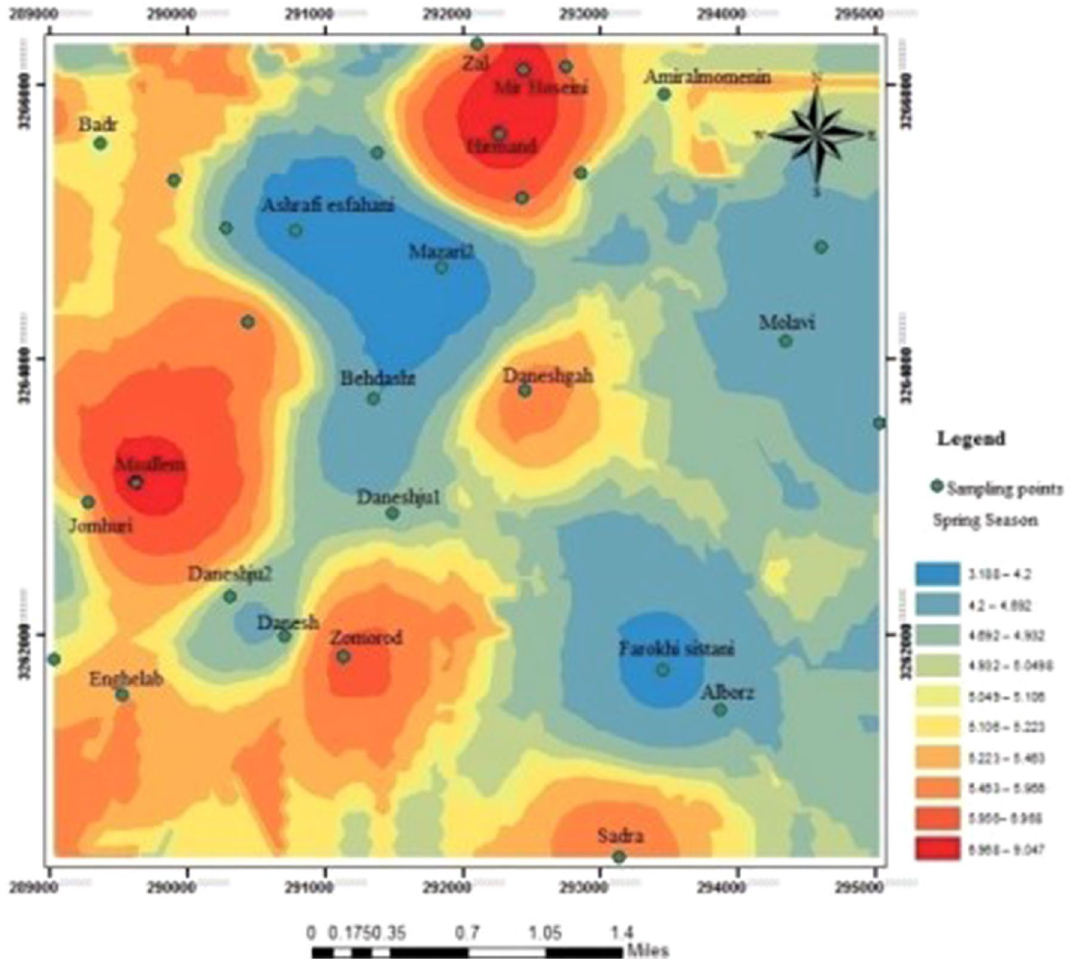
Fig. 5 Landing dust mapping schedule of spring